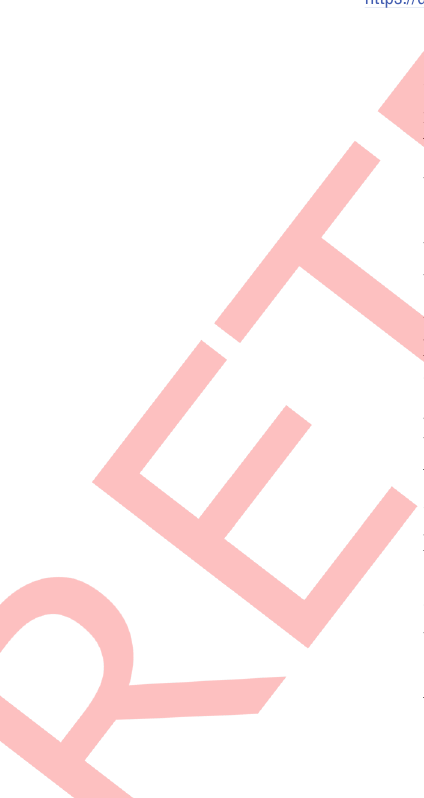
Fig 2. Interaction analysis of smoking and mode of treatment. Interaction analysis based on presence of exposure variables (smoking and intra-arterial thrombolysis [IA-thrombolysis]), presenting crude and adjusted relative risk (RR). Reference category refers to non-smokers who received mechanical thrombectomy without IA-thrombolysis. The model is adjusted for the following covariates: age, sex, hypertension, atrial fibrillation, baseline NIHSS, and time to endovascular treatment.